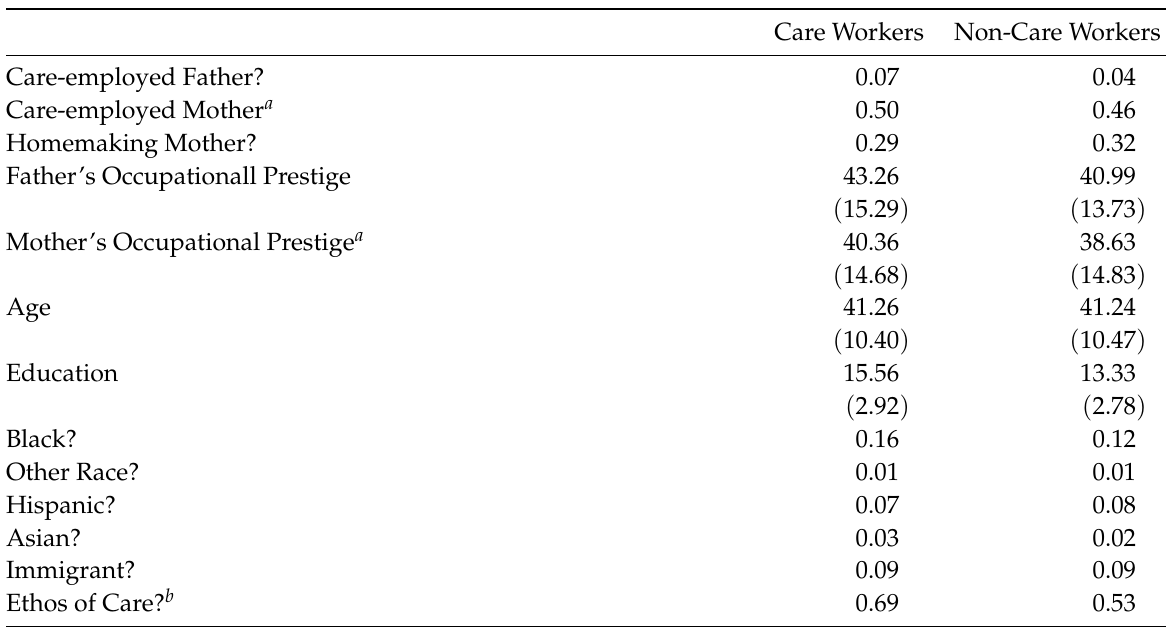
Table 1: Means (Standard Deviations) by Care Status